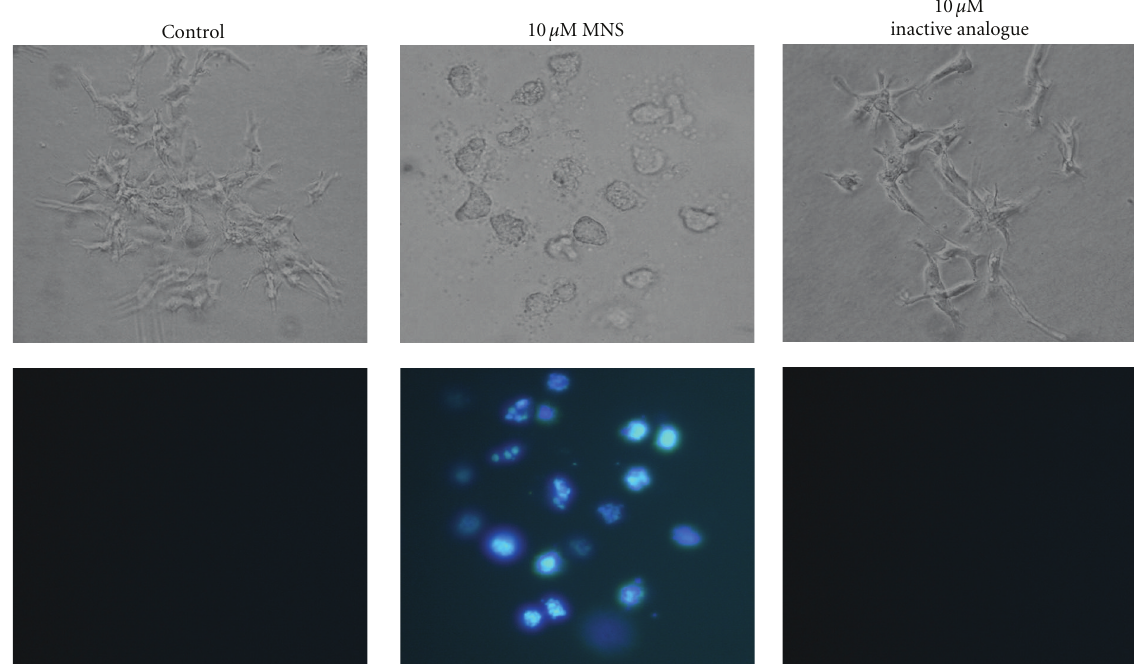
Figure 4: MNS disrupts preformed 143B colonies. Images of the metastatic 143B cell colonies incubated for 24 hours in presence of 10 μ M MNS, 10 μ M of the inactive analogue, or 1% DMSO as a vehicle control. The membrane-impermanent fluorescent stain 4 (cid:4) , 6-diamidino-2- phenylindole (DAPI, 0.1 μ g/mL) was added 8 hours after incubation began. Fluorescent microscopy was used to obtain photomicrographs (bottom panel). This figure shows representative images from three independent experiments, each with two to three wells per